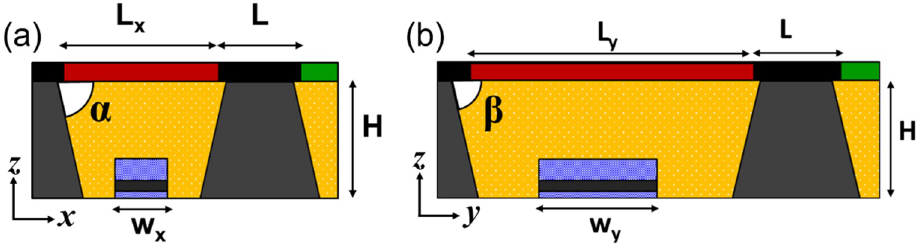
Figure 5. Cross‐sectional views of device B in the ( a ) x-z panel, and ( b ) y-z plane. Figure 5. Cross-sectional views of device B in the ( a ) x-z panel, and ( b ) y-z